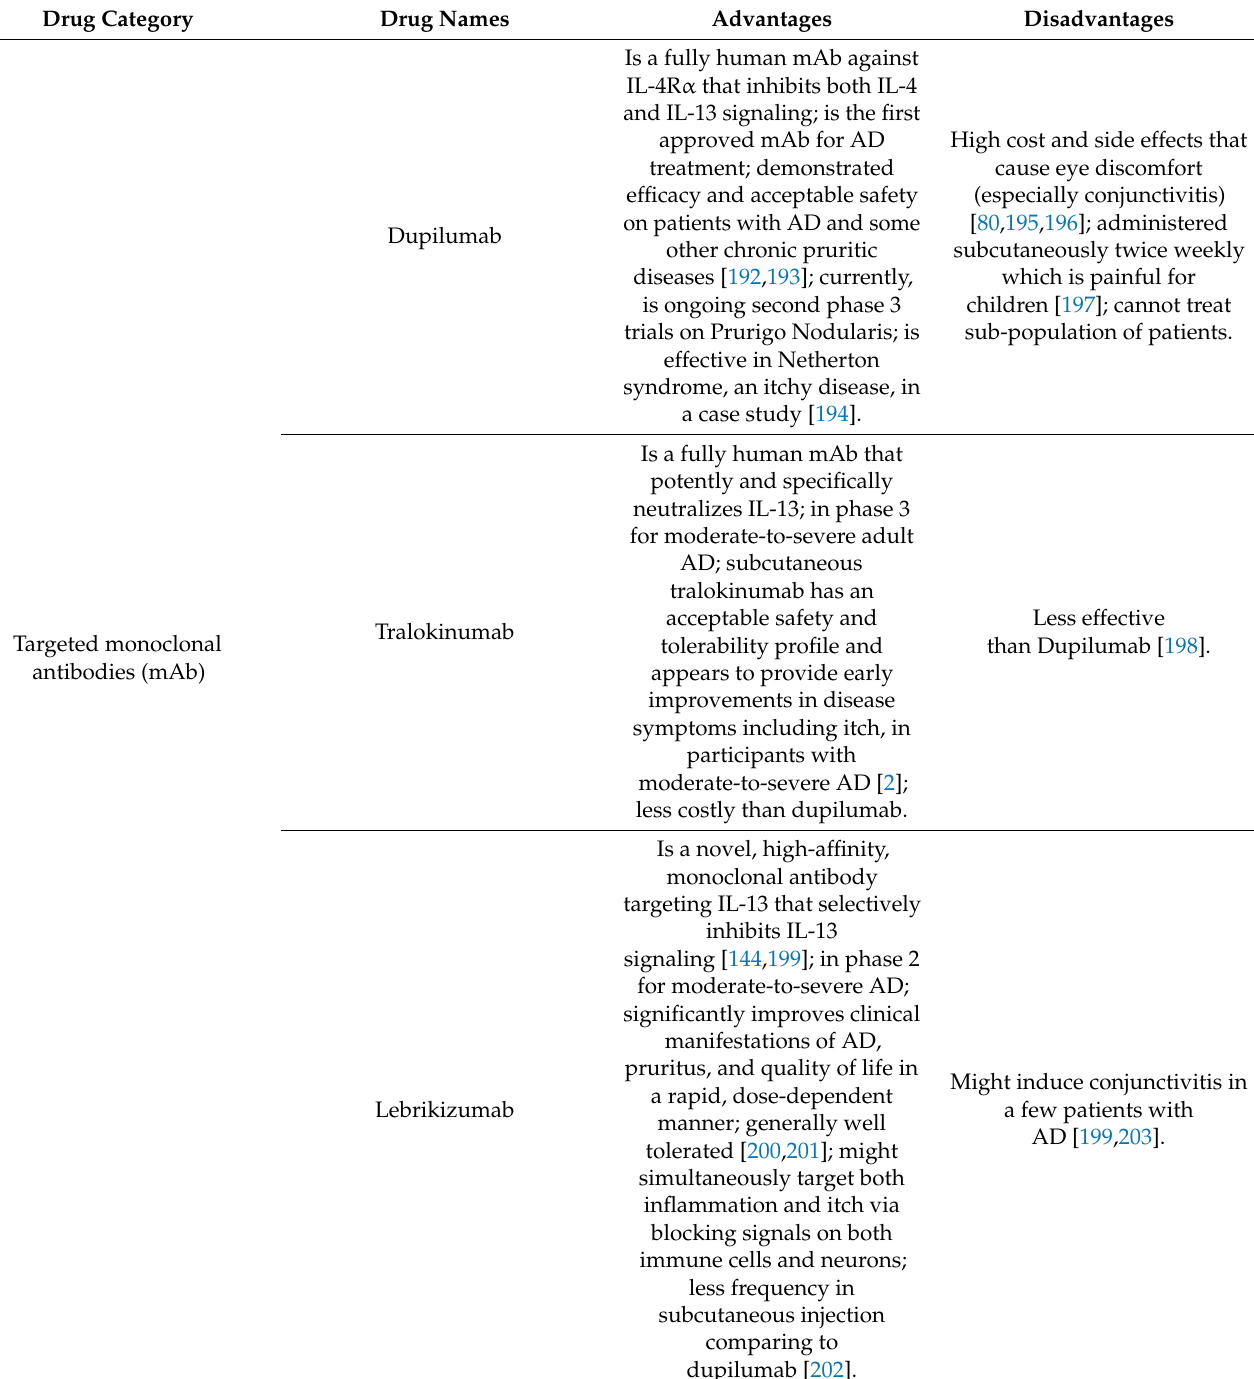
Table 1. Current advanced therapeutical development for chronic